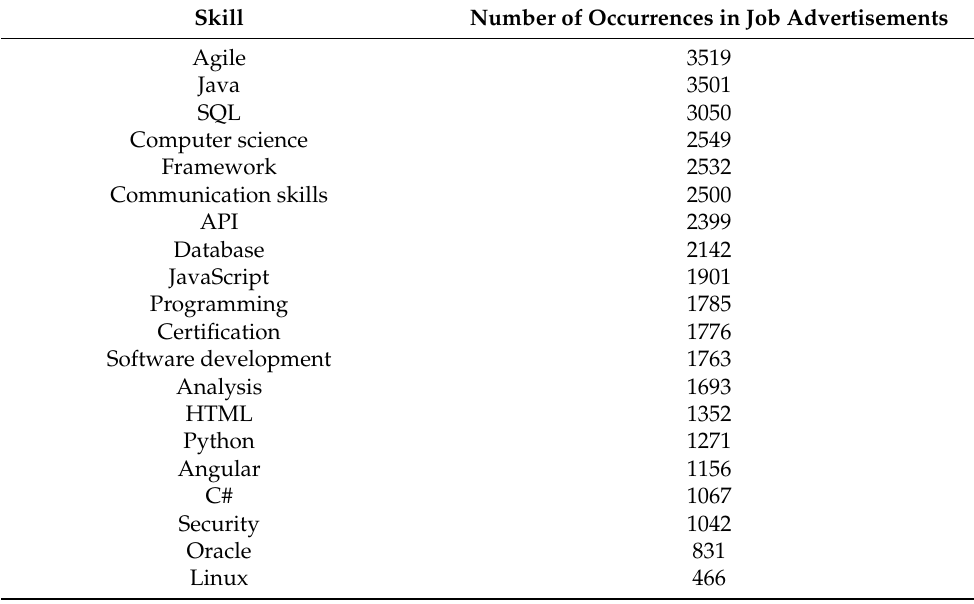
Table 9. Top 20 most frequent skills in the analyzed job